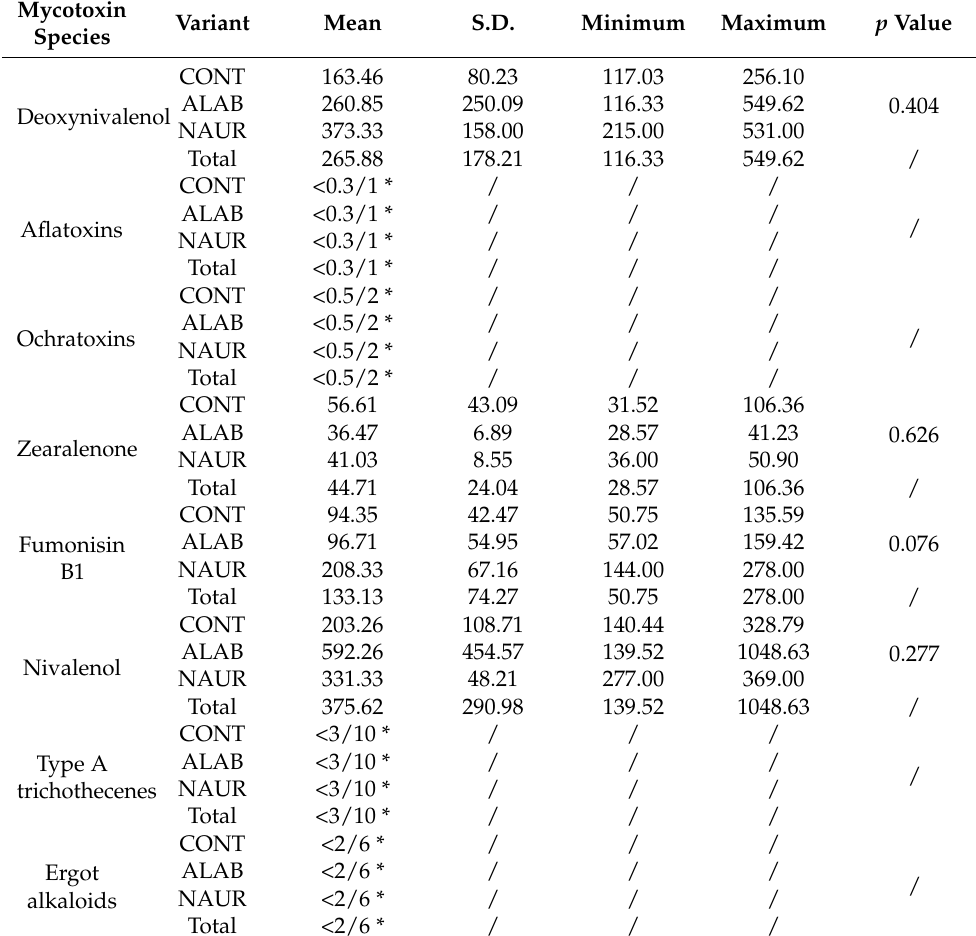
Table 5. The content of regulated mycotoxins in corn silage variants in µ g/kg. Mycotoxin Species